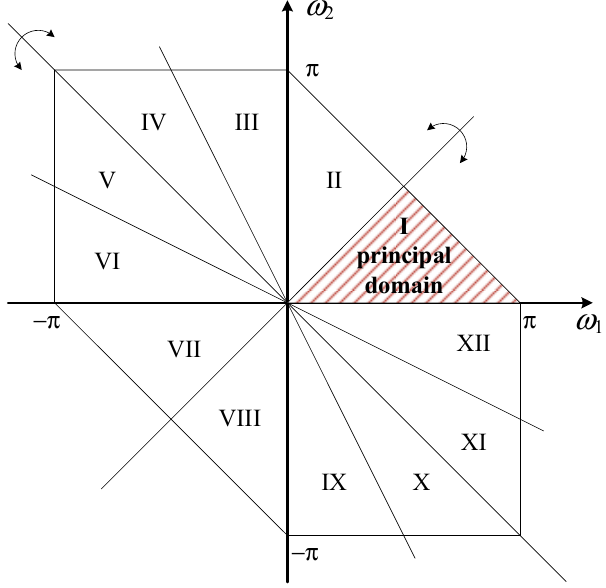
Figure 1. Regions of symmetry of BS transform (region I area—principal domain).